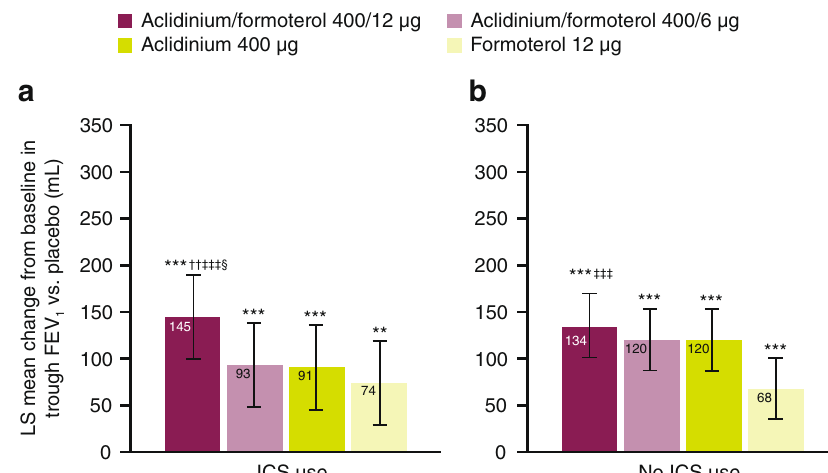
Fig. 2 LS mean change from baseline in trough FEV 1 vs. placebo at week 24 in ICS users a and non-ICS users b (pooled ITT population) ** P < 0.01 vs. placebo; *** P < 0.001 vs. placebo; †† P < 0.01 vs. aclidinium 400 μ g; ‡‡‡ P < 0.001 vs. formoterol 12 μ g; § P < 0.05 vs. aclidinium/ formoterol 400/6 μ g. Analyses based on the mixed model for repeated measures: treatment effects and treatment comparisons. Error bars represent 95% con fi dence intervals. Patient numbers for the placebo groups were: for patients using ICS, n = 137, for patients not using ICS, n = 254. FEV 1 forced expiratory volume in 1 s, ICS inhaled corticosteroid, ITT intent-to-treat, LS least squares, mL